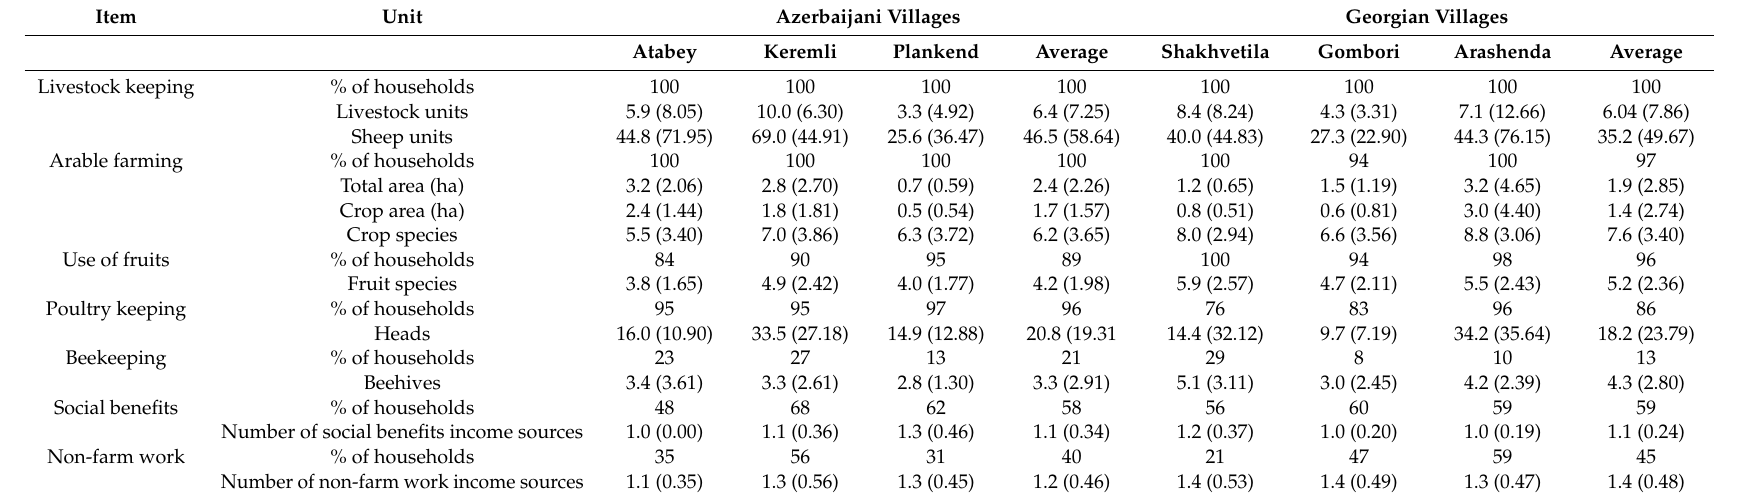
Table 3. Overview of income sources of surveyed